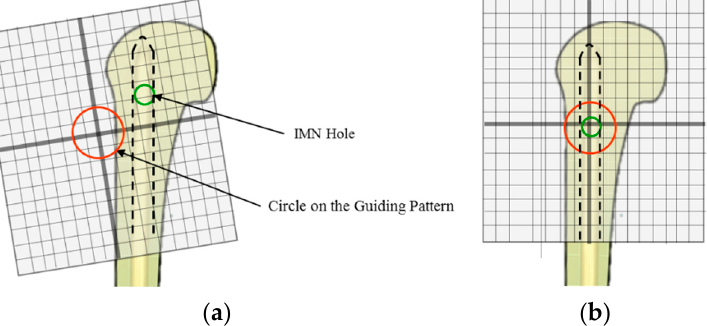
Figure 6. Confirmation of position of the two holes relative to each other. ( a ) Misaligned state. ( b ) Aligned state.